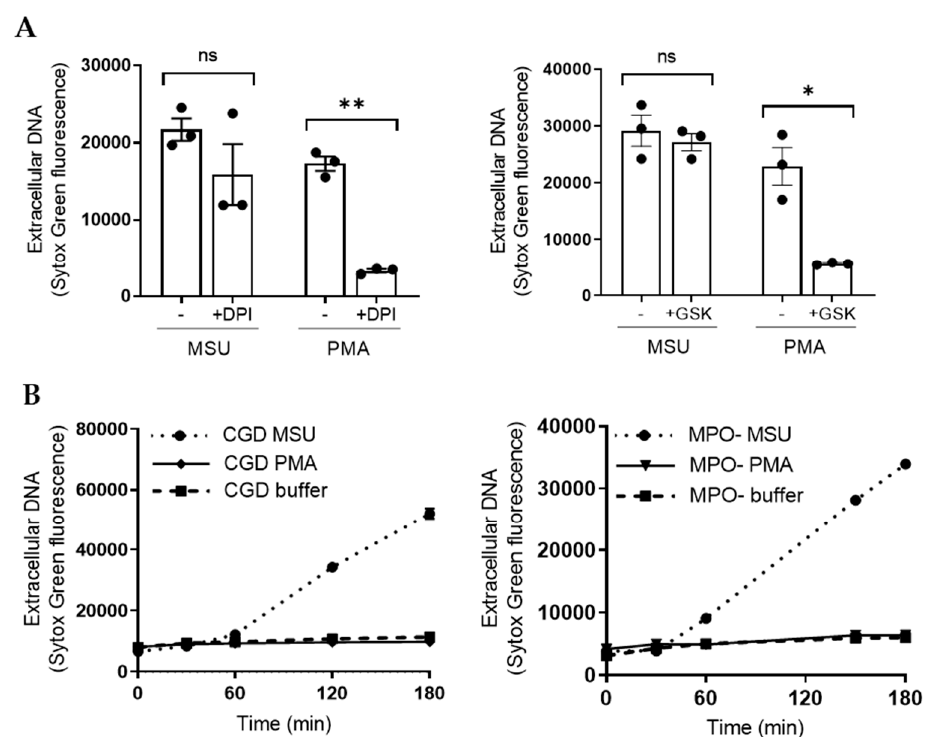
Figure 6. MSU crystal induced NET formation is independent of ROS. ( A ) Neutrophils were pre-treated with the NADPH-oxidase inhibitors DPI (10 µ M) or GSK (20 µ M) and thereafter stimulated with MSU crystals (300 µ g / mL) or PMA (50 nM) before NET formation was evaluated by Sytox green measurement after 3 h. As opposed to PMA stimulated neutrophils, MSU treated neutrophils formed NETs also in the presence of the inhibitors. Mean +/ − SEM of three independent experiments are shown, a paired t -test was used for statistical comparisons. ( B ) Neutrophils from one patient with CGD (left) as well as from one individual with complete MPO-deficiency (MPO-, right) formed NETs in response to MSU (300 µ g / mL), dotted lines, but not to PMA (50 nM, solid lines). * p ≤ 0.05 and ** p ≤ 0.01. ns = not significant.